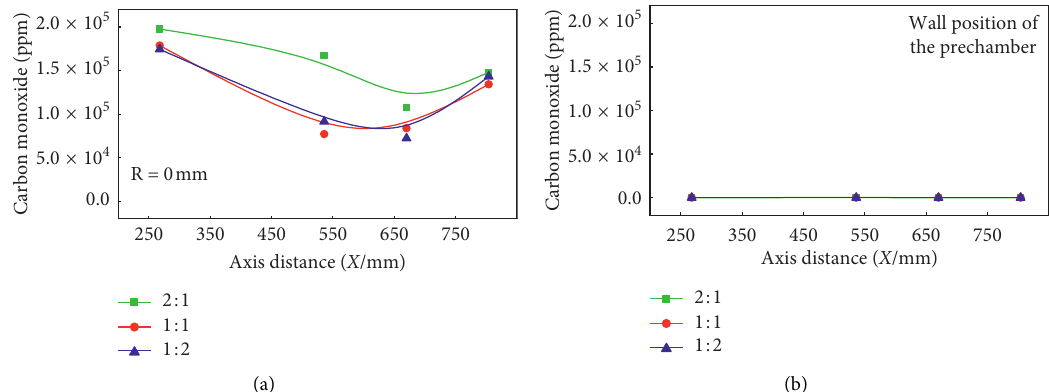
Figure 8: CO concentration profiles along axis distance for different ISA/OSA.